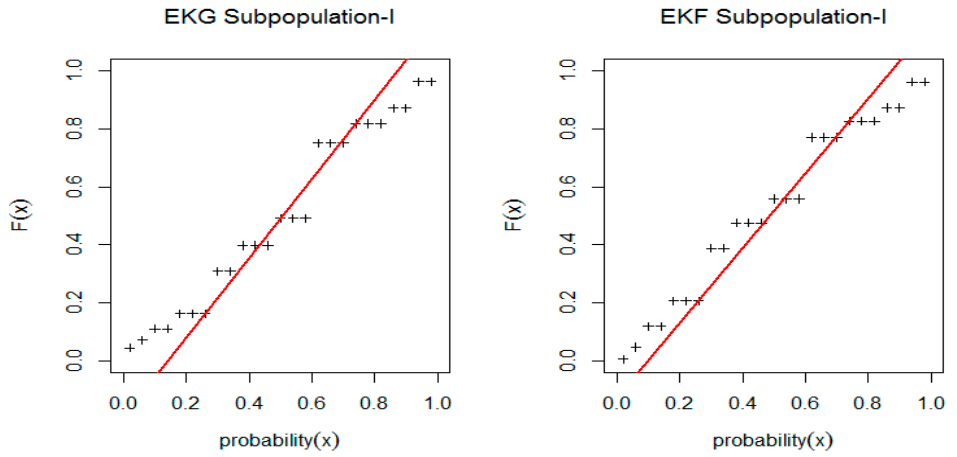
Figure 4. PP-plot for EKG and EKF distribution for Subpopulation I.